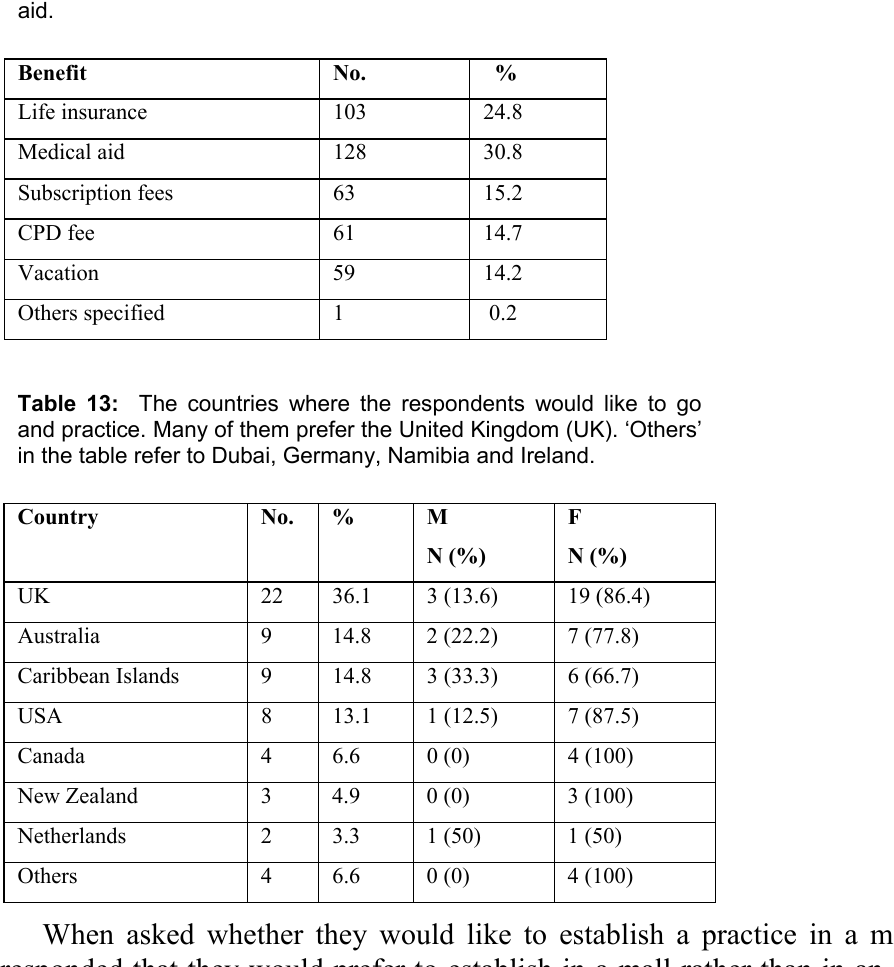
Table 12: Showing the benefits that the respondents think an optometrist should get when employed in an existing practice. The most common choice is medical aid.